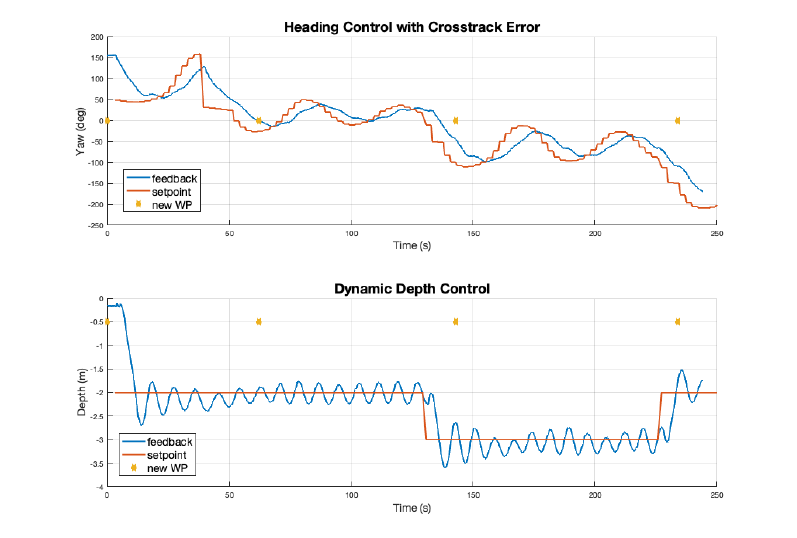
Figure 13. A mission plan to inspect the outside of the seaweed farm in Neptus ( left ). In Stonefish, the AUV follows 4 waypoints in straight lines around the extremities of the farm (shown as crosses in the Neptus figure) at a depth of 2.5 m, and then inspects the inside ( right ). Since this farm has two parallel algae lines, the vehicle does three close-by passes after the initial survey. The vehicle then moves out of the farm.